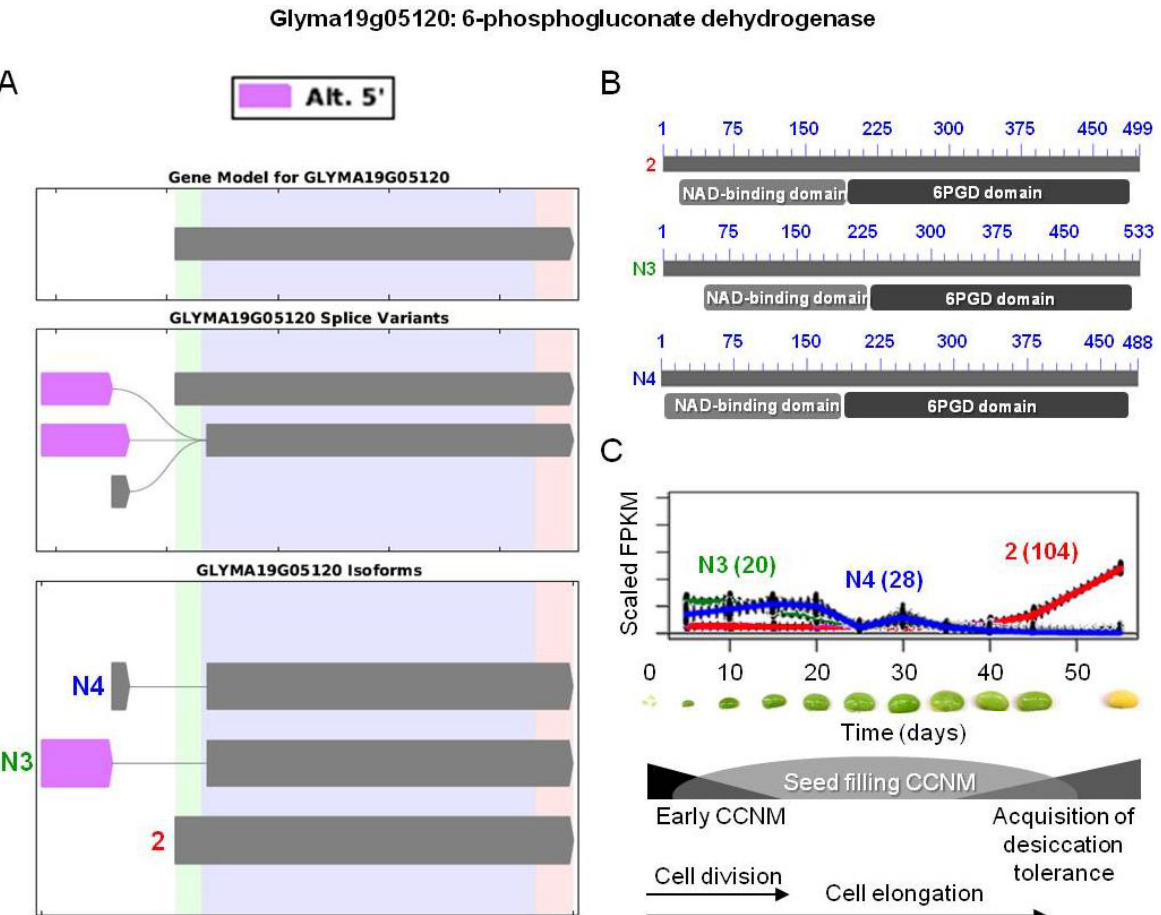
Figure 4. AS of 6-phosphogluconate dehydrogenase involved in oxidative pentose phosphate pathway. ( A ) SpliceGrapher representations of individual isoforms detected during soybean embryo development. Only Glyma19g05120.2, N3, and N4 (corresponding to 2, N3, and N4) were differentially expressed. Alternative 5' splicing yielded these novel isoforms. ( B ) Proteins resulting from these three transcripts with the respective positions of NAD-binding domains (pfam03446) and 6-phosphogluconate dehydrogenase (6PGD) C-terminal domains (pfam00393). Domain-related information was obtained from NCBI [97]. Numbers in blue represent amino acid residues in the individual proteins. ( C ) Overlaid expression profiles of Glyma19g05120.2, N3, and N4, obtained from SplineCluster. Numbers shown in parenthesis represent the isoform clusters. Representative developing soybean embryos are shown for each time point along with a temporal representation of processes occurring during embryo